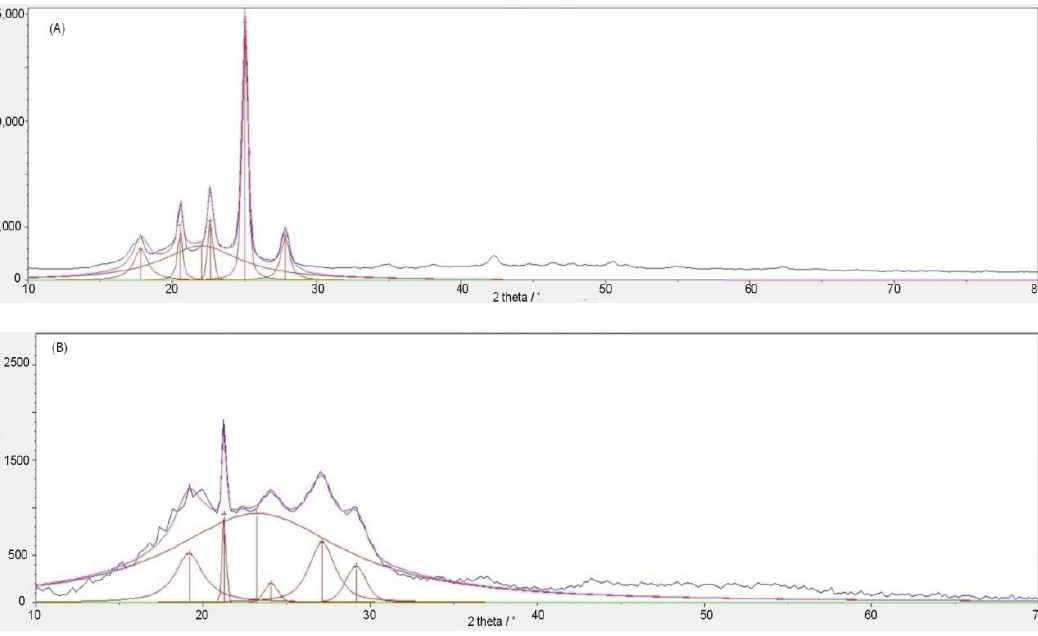
Figure 3. Examples of the X-ray diffractions with resolved diffraction reflections originating from the crystalline and amorphous phases: ( A ) PE7M; ( B ) PBT7A.